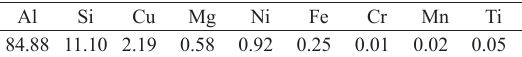
Table 1. Chemical composition (weight. %) of Al-11wt%Si alloy determined by X-ray microanalysis method.